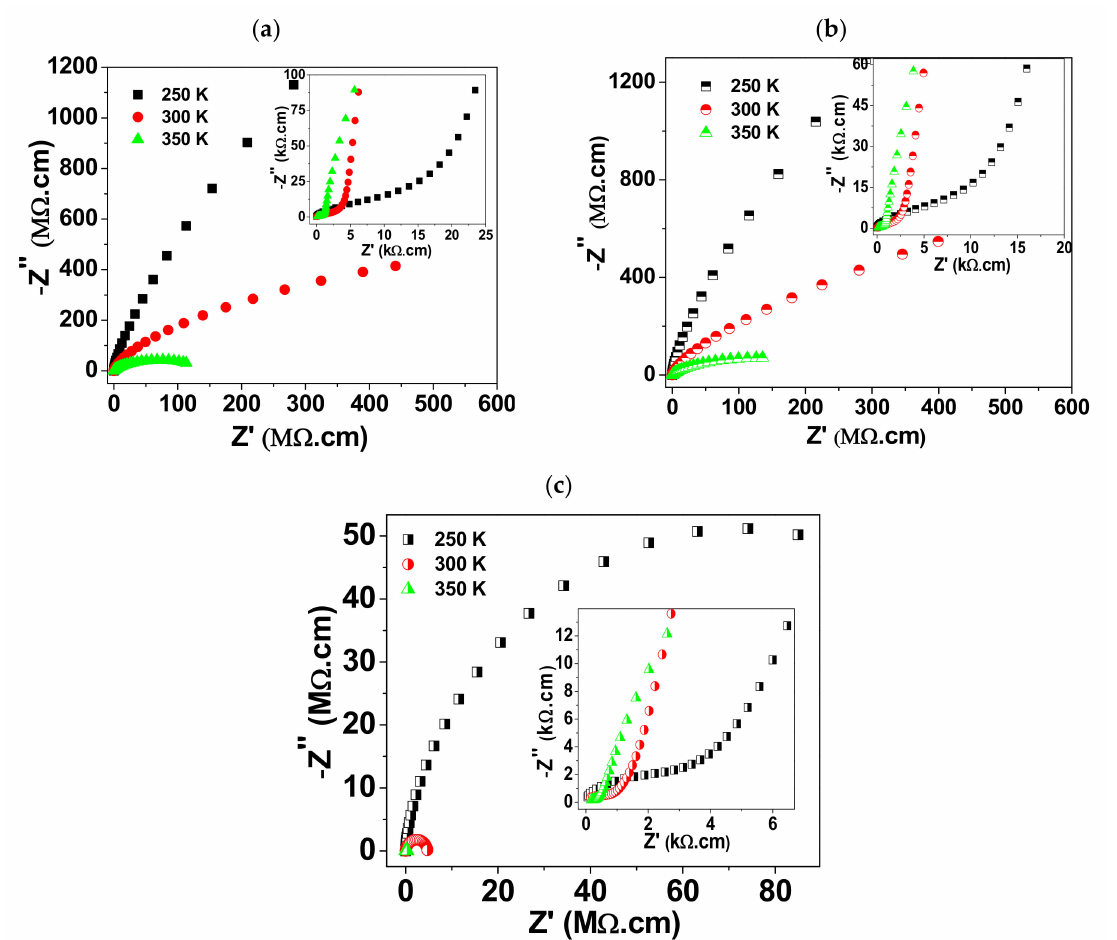
Figure 4. –Z (cid:48)(cid:48) versus Z (cid:48) plots at selected temperatures for ( a ) BCTO-950, ( b ) BCTO-975, and ( c ) BCTO-990 ceramic samples. Insets show the expanded view of the high frequency region (close to the origin) for each